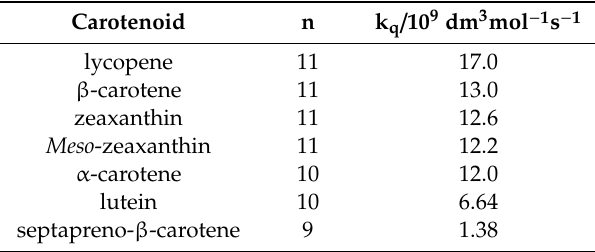
Table 3. Second-order rate constants (k q ) for the carotenoid quenching of 1 O 2 in